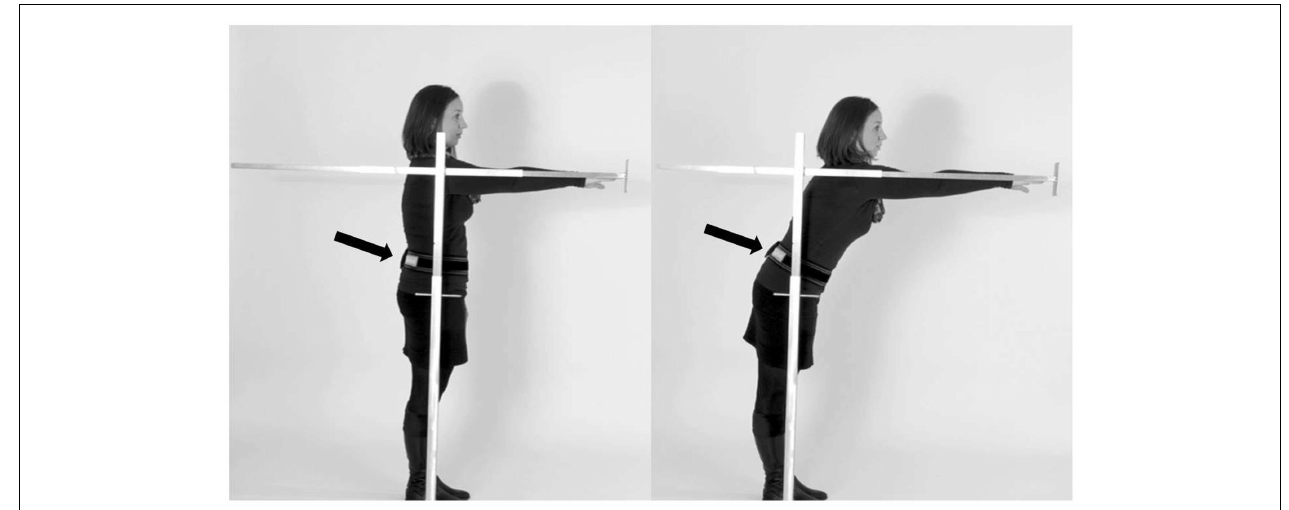
FIGURE 1 | Performance of the instrumented functional reach test (SEH) . Participants were asked to stand upright (A) , reach forward as far as possible by pushing the rod, and then to hold the position for 10s (B) .The sensor was worn at the lower back